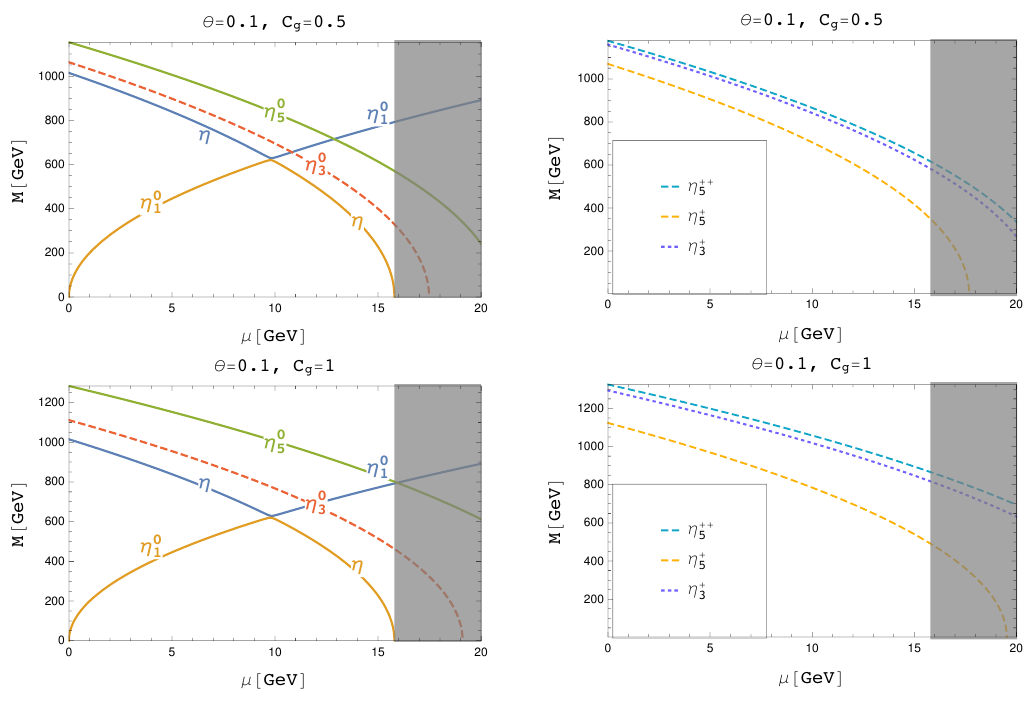
Figure 7 . Plots of the A L - A R spectra at NLO, in the ‘custodial’ case described in the text, including the gauge term of eq. (3.29). Note that the triplet and (cid:12)ve-plet are squeezed towards the singlet as C g ! 0, while the masses of the gauge and custodial singlets, respectively (cid:17) and (cid:17) 0 not depend on C g in this custodial